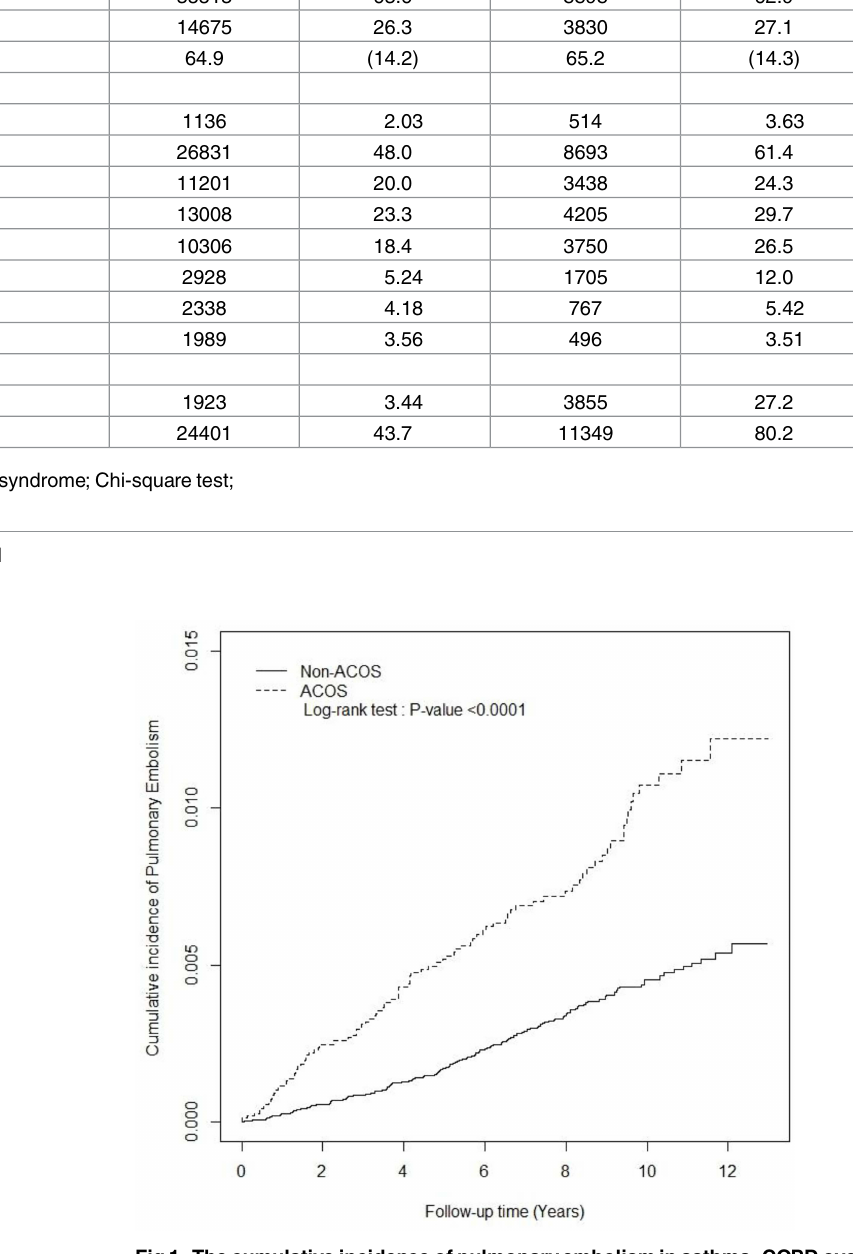
Fig 1. The cumulative incidence of pulmonaryembolismin asthma–COPD overlap syndrome(ACOS) (dashedline)and non-ACOS